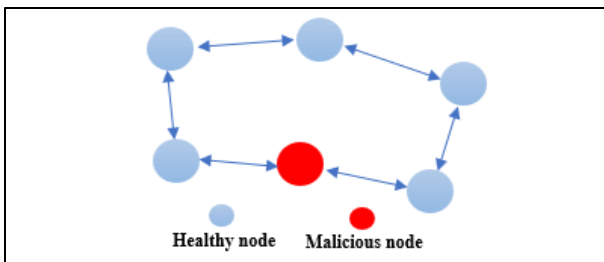
Figure 2. Malicious node injection attack